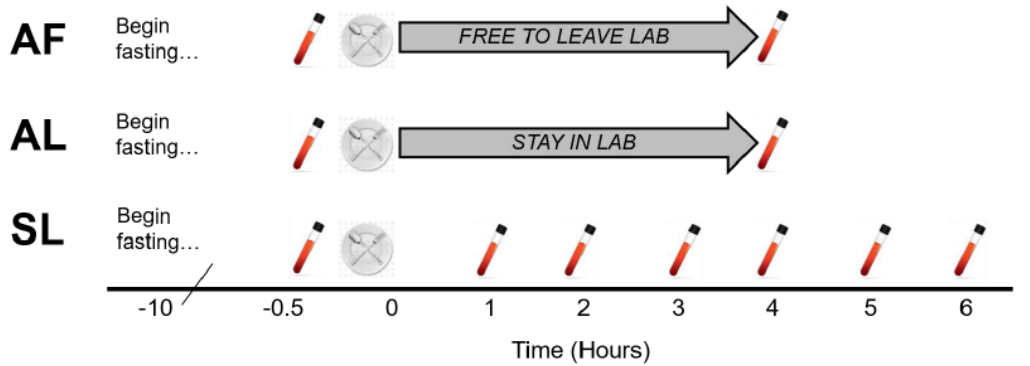
Figure 1. Protocol for the three meal trials. Participants completed 3 meal trials in random order. The Standard in Lab (SL) trial featured blood draws from a venous catheter at baseline and hourly for 6 h post-meal. The Abbreviated in Lab (AL) trial included single blood draws at baseline and 4 h post- meal, while the participants remained in the lab. In the Abbreviated with Freedom (AF) trial, participants vacated the lab between the meal and the 4-h blood